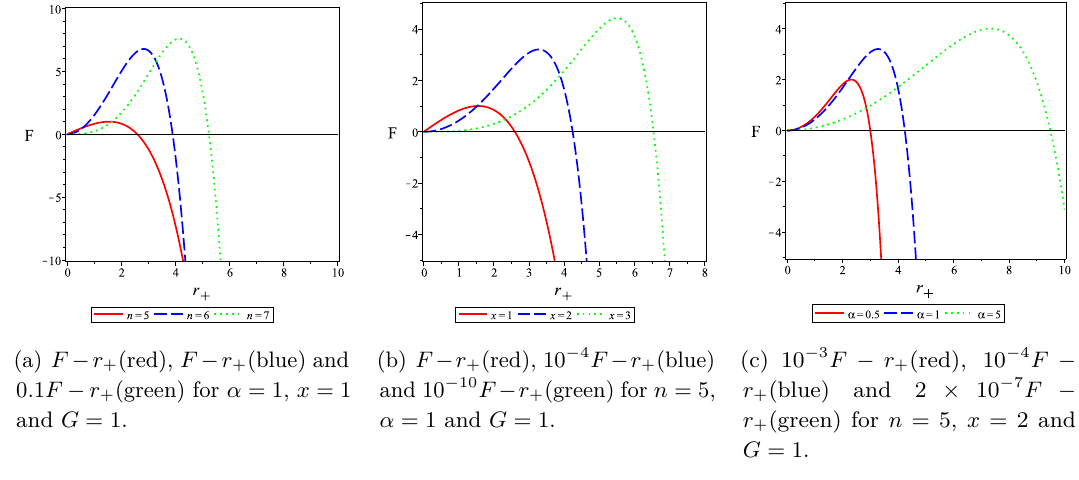
Figure 8 . Behavior of the free energy versus r + for k = 1 for “ − ” sign